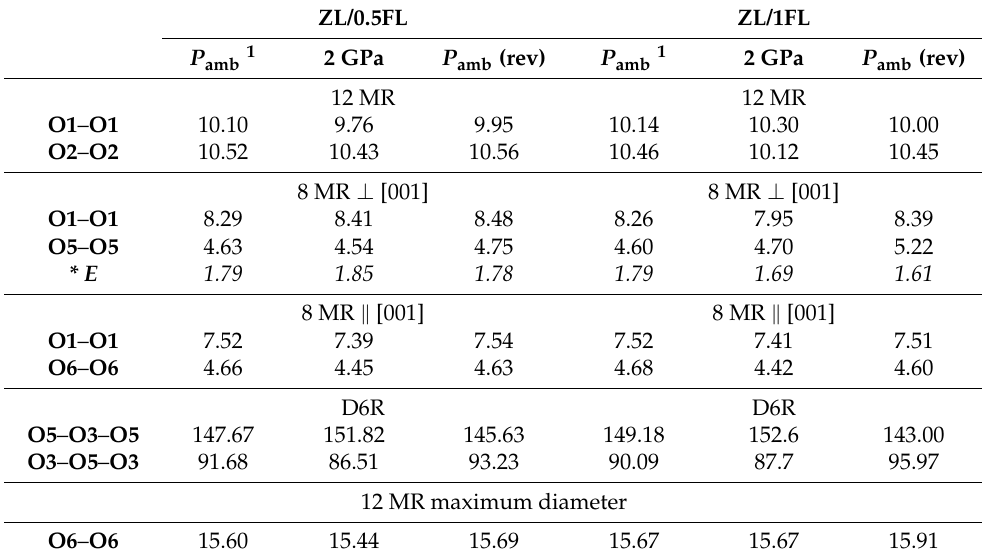
Table 2. Experimental framework distances obtained from the refinements performed on the ZL/0.5FL and ZL/1.0FL composites at P amb (from Ref. [56]), at 2 GPa and upon decompression ( P amb (rev)). 1 From ref.